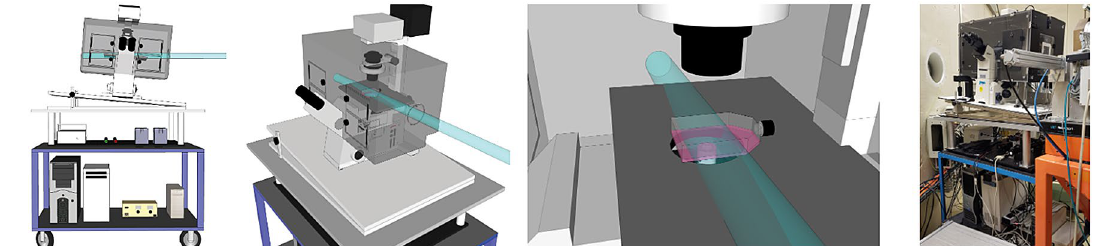
Figure 1. Overview of the imaging setup. Schematic overview of the live-cell microscopy setup at KVI-CART facility in Groningen, The Netherlands. The microscope is positioned on a transportable cart, on a platform at a low angle (~ 5°). The last photograph is the microscopy setup after installation in the